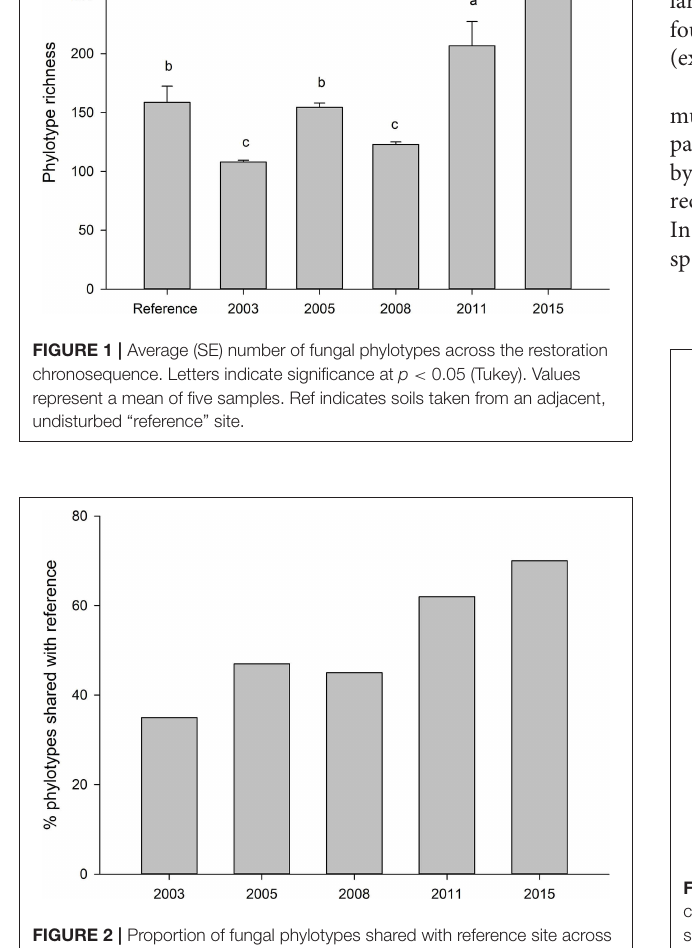
Frontiers in Forests and Global Change |